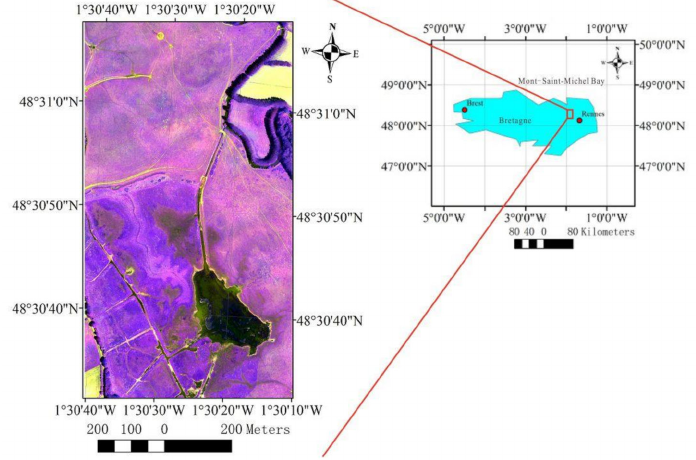
Figure 1. Location of unmanned aerial vehicle (UAV)